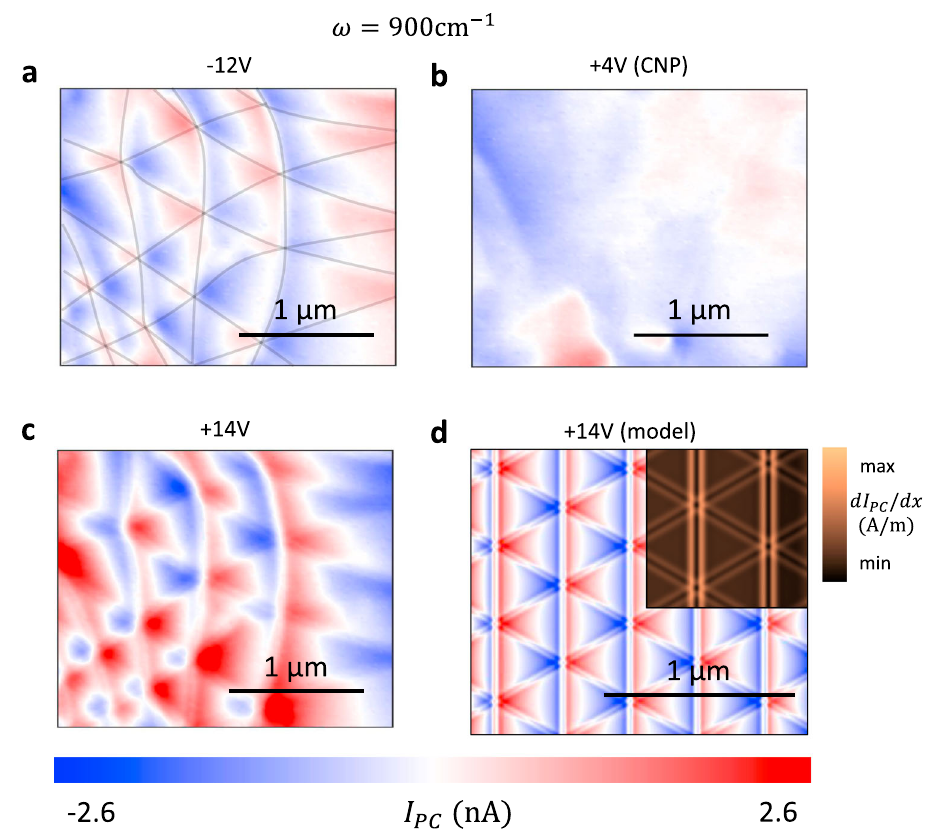
Fig. 2 Thermoelectric origin of the photocurrent in TBG. a – c Gate voltage dependence of the photocurrent ( I PC ) at ω = 900 cm − 1 and T ¼ 300K. Gate voltage is indicated above each panel. d Calculated photocurrent pattern using the Shockley – Ramo formalism 24 with material parameters corresponding to V ¼ þ 14V (more details in Supplementary Note 3). The top-right inset shows the calculated image of d I G